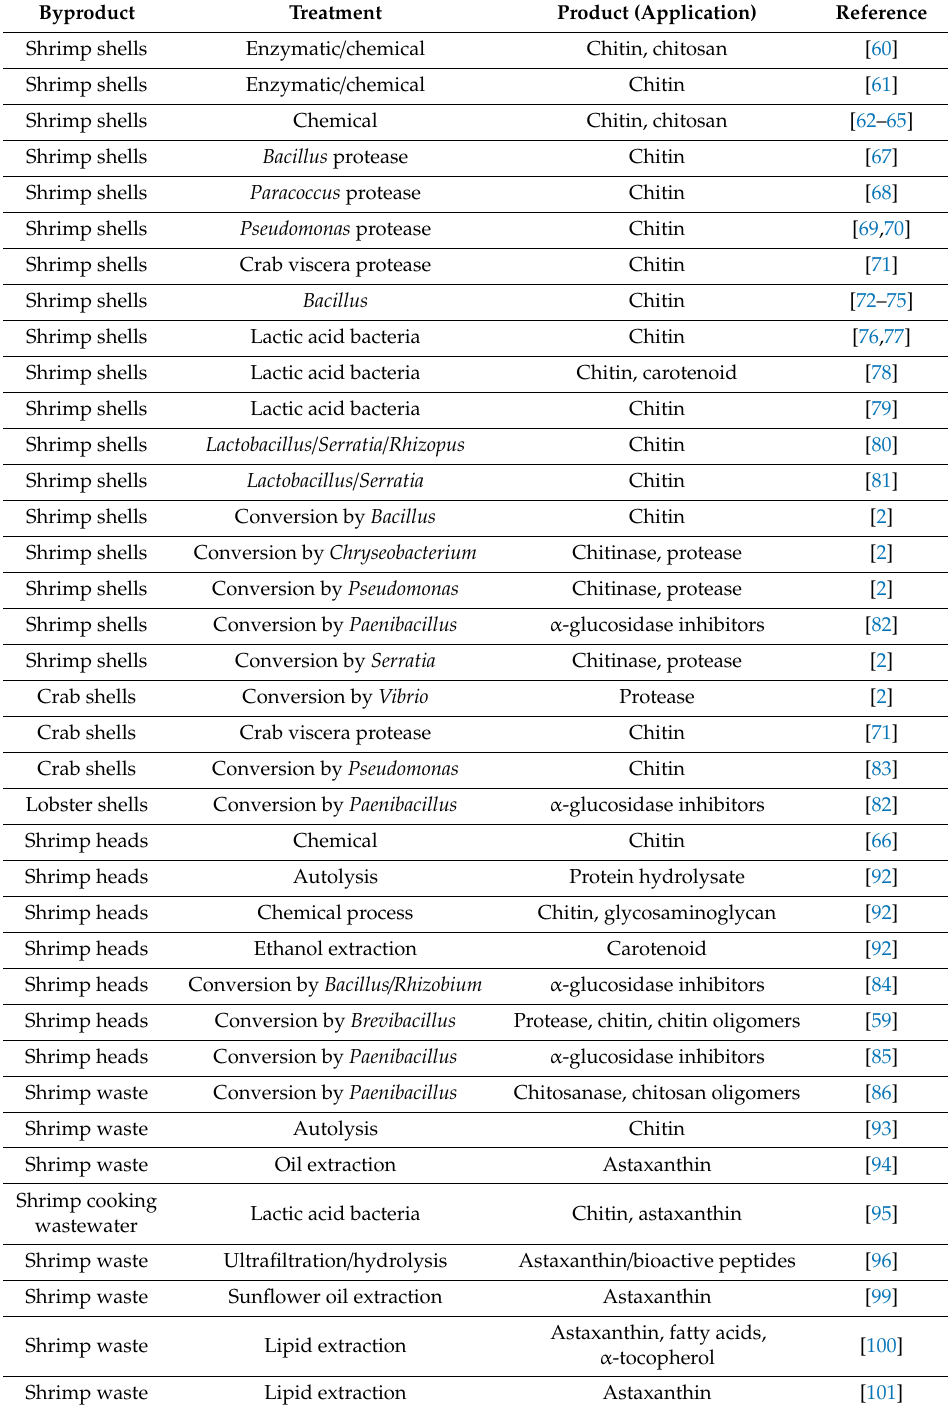
Table 2. Use of shrimp and crab processing